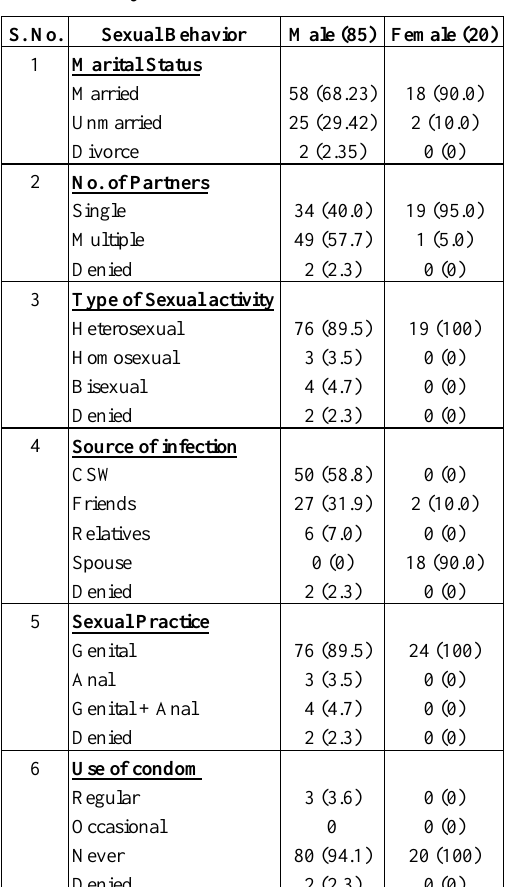
Table 1 : Distribution of the Patients by their Sexual Behavior